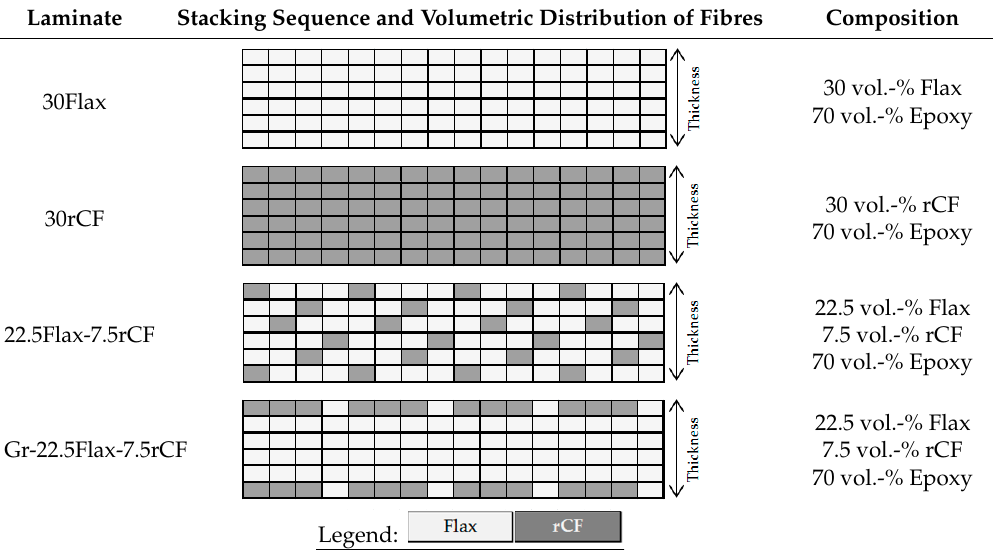
Table 1. Nomenclature, composition and schematic drawings of the volumetric distribution of flax (light grey) and rCF (dark grey). Total fibre volume content for each composite was approximately 30%. The volumetric rCF to flax ratio in the outer layers of the Gr-22.5Flax-7.5rCF laminate was rCF/flax = 3:1 (intralayer). The four inner layers contained 100% flax fibres, resulting in a combination of intralayer and interlayer hybrid. The same total amount of flax and rCF was used for the 22.5Flax-7.5rCF laminate (pure intralayer). Stacking Sequence and Volumetric Distribution of Fibres 30Flax